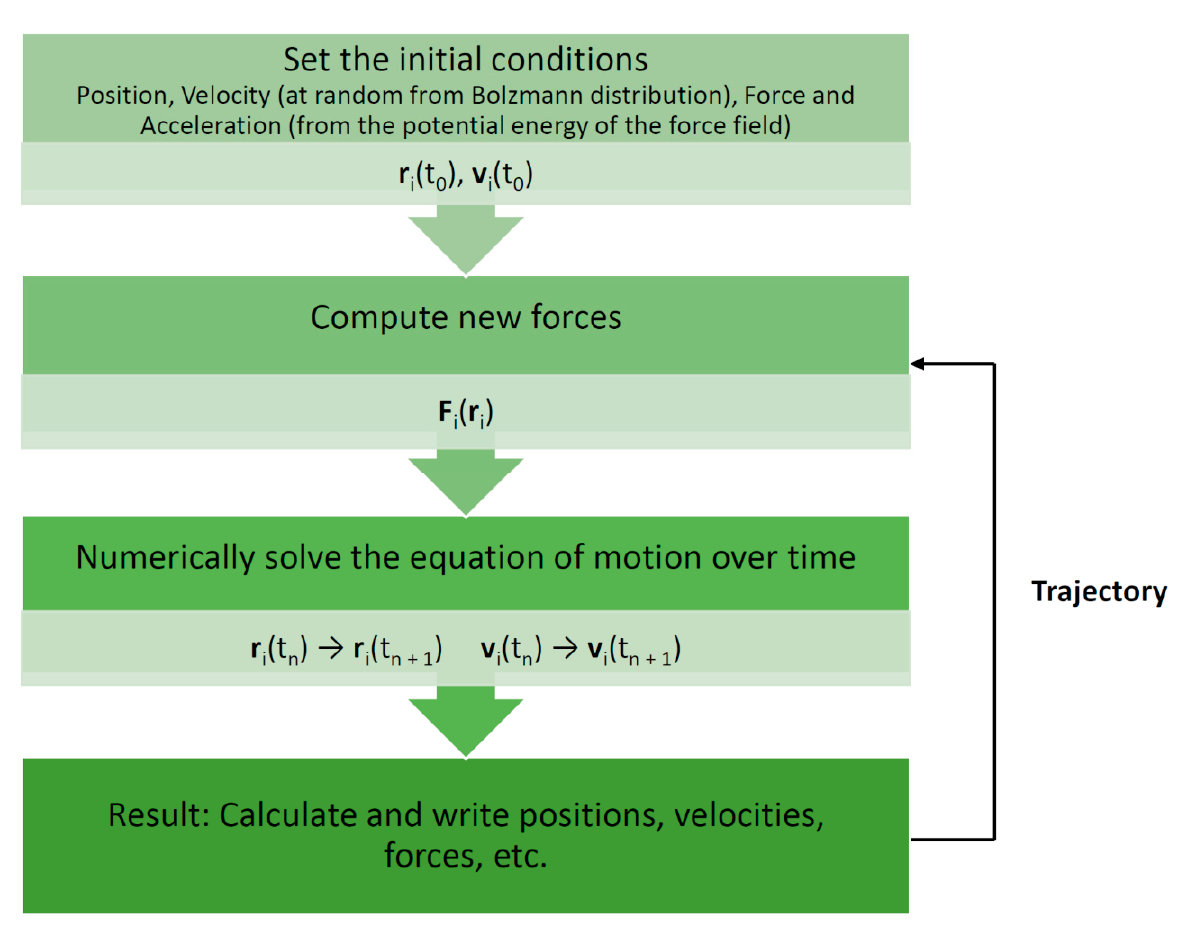
Figure 1. Basic molecular dynamics simulation algorithm. Each particle moves according to Newton’s second law or the equation of motion, F = ma (where F is the force exerted on the particle, m is its mass, and a is its acceleration under a potential field), such that the particles in the system are captured in the trajectory [1,13]. r—position; v—velocity; t—time.